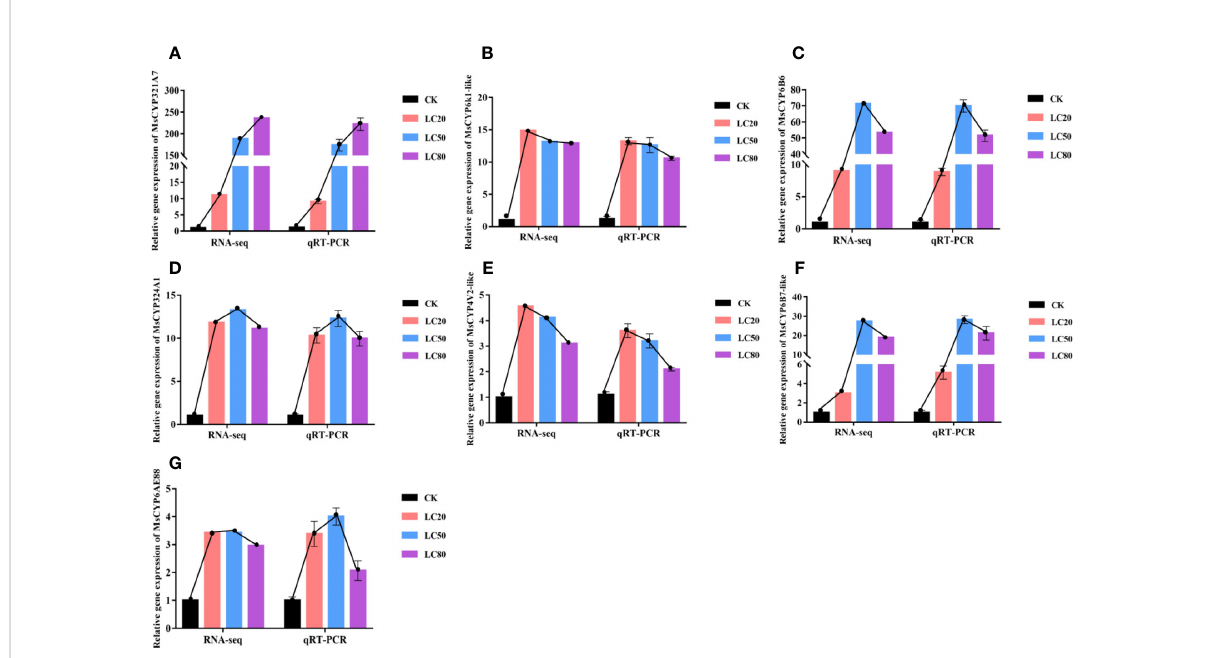
FIGURE 5 Comparison of relative fold change determined from RNA-seq and qRT-PCR analysis of the same samples. (From A – G the genes are MsCYP321A7 , MsCYP6k1-like , MsCYP6B6 , MsCYP324A1 , MsCYP4V2-like , MsCYP6B7-like , and MsCYP6AE88 ,